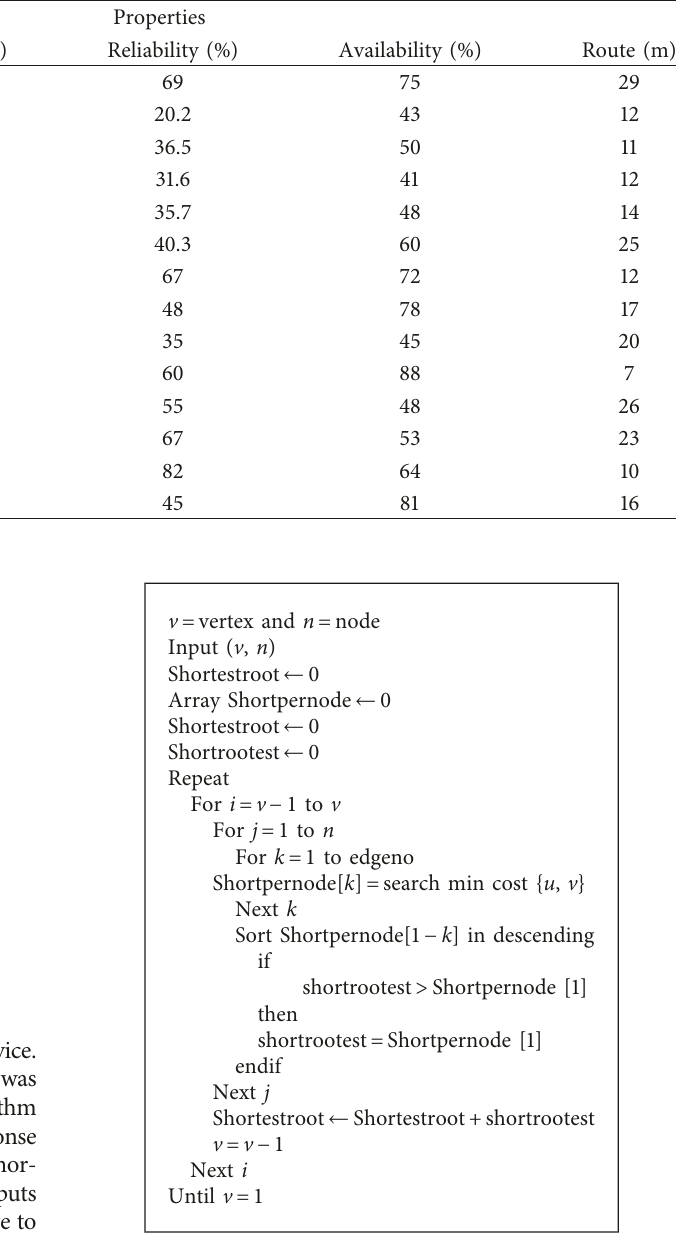
A LGORITHM 3: Shortest route DP